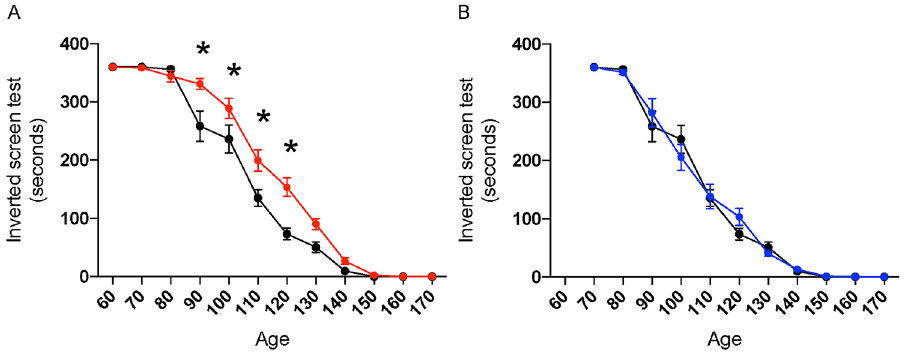
Figure 1. Oxaloacetate treatment from the presymptomatic stage improves the neuromuscular strength of SOD1 G93A mice in the symptomatic stage. ( A ) Injection of oxaloacetate at 2 g/kg body weight/5 days a week from the presymptomatic stage (60 days old, red) delayed the decline in neuromuscular function measured using an inverted screen test. The vertical axis shows the total hanging time from three trials of the inverted screen test, and the horizontal axis indicates the age of measurement. The line graphs show mean ± S.E.M, which were for oxaloacetate-injected group 330.8 ± 9.3 versus control group 258.4 ± 26.2 at age 90, 288.8 ± 17.4 versus 236.1 ± 24 at age 100, 199.4 ± 18.5 versus 135.5 ± 14.5 at age 110, 153.8 ± 15.7 versus 73.58 ± 10.1 at age 120. Asterisks indicate a significant difference between the oxaloacetate injected (red) and control group of non- injected (black) SOD1 G93A mice by repeated measure two way-ANOVA, p < 0.01. ( B ) The group treated from the symptomatic stage (110 days old, blue) did not show differences from the control group of non-injected SOD1 G93A mice (black, same mice as A ). N = 12 mice per group.